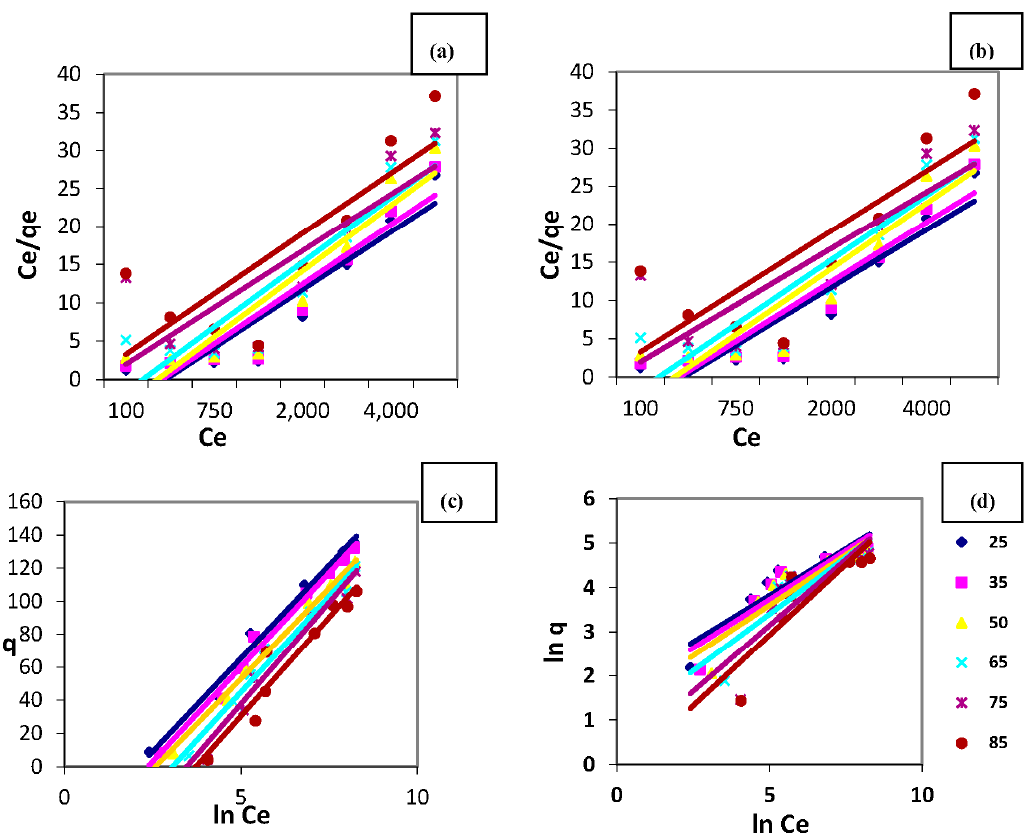
Figure 15. Equilibrium isotherm models for the copper sorption process at different solution temperatures (amount of MANSG = 0.25 g; agitation speed = 200 rpm; solution volume = 25 mL; pH = 7): ( a ) Langmuir isotherm model; ( b ) Freundlich isotherm model; ( c ) Temkin isotherm model; ( d ) Elovich isotherm model.